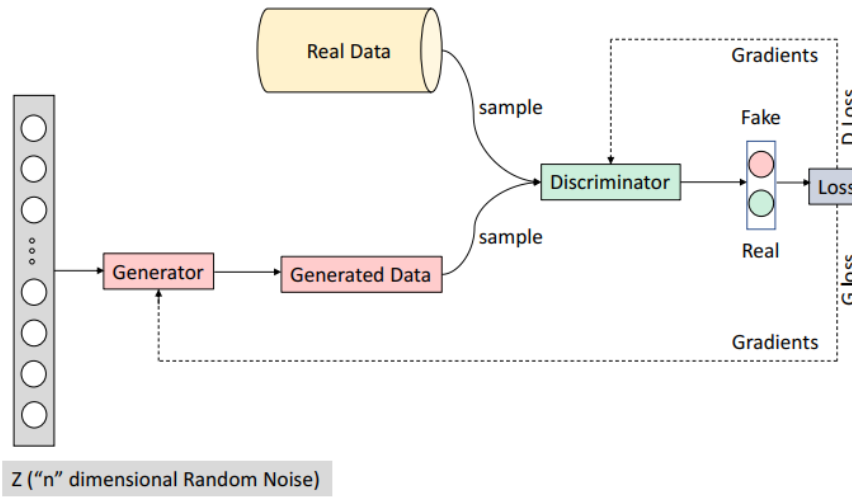
Figure 1. Sketch map of the GAN architecture [34].